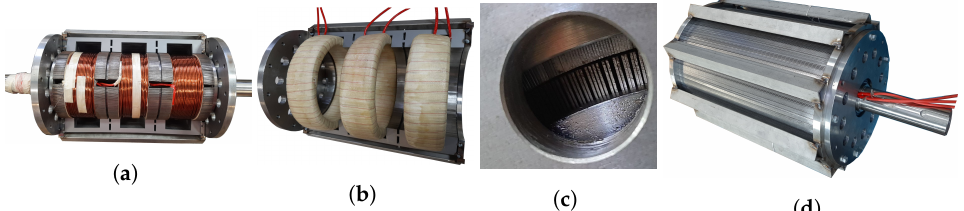
Figure 10. Complete assembly of the rotary transformer: ( a ) rotor in stator half; ( b ) full assembly; ( c ) inspection of the air gap; ( d ) rotary transformer mounted in testing.